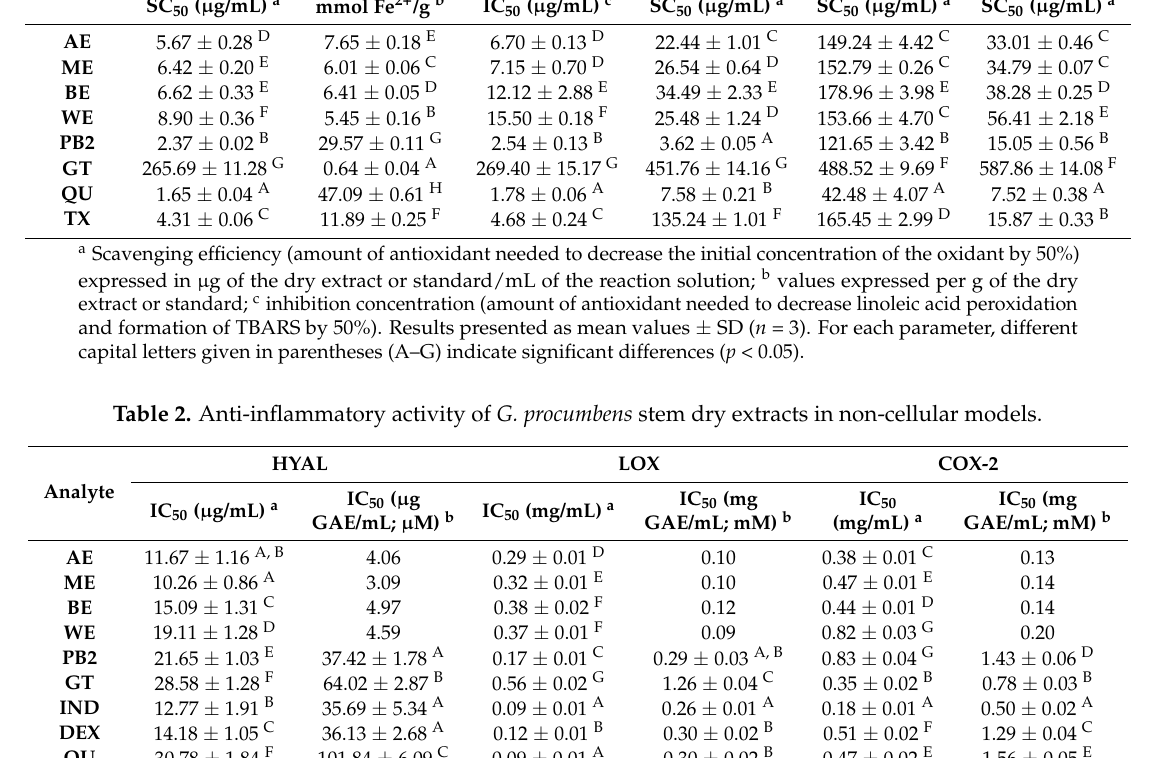
Table 1. Antioxidant activity of G. procumbens stem dry extracts in non-cellular models. Analyte